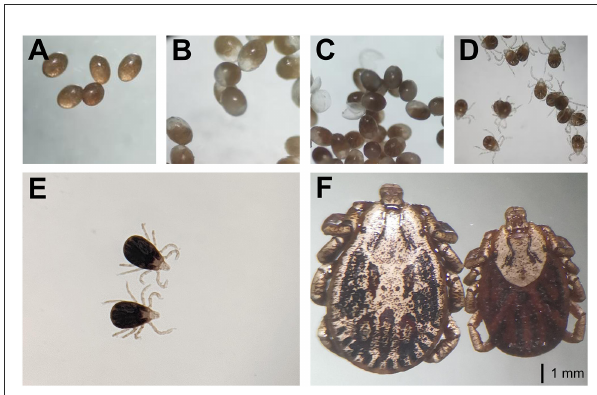
FIGURE4 The laboratory-rearing of D. nuttalli . All figures used the same ruler (1mm). (A) Prophase of eggs. (B) Metaphase of eggs. (C) Anaphase of eggs. (D) Larva. (E) Nymphs. (F) Female and male